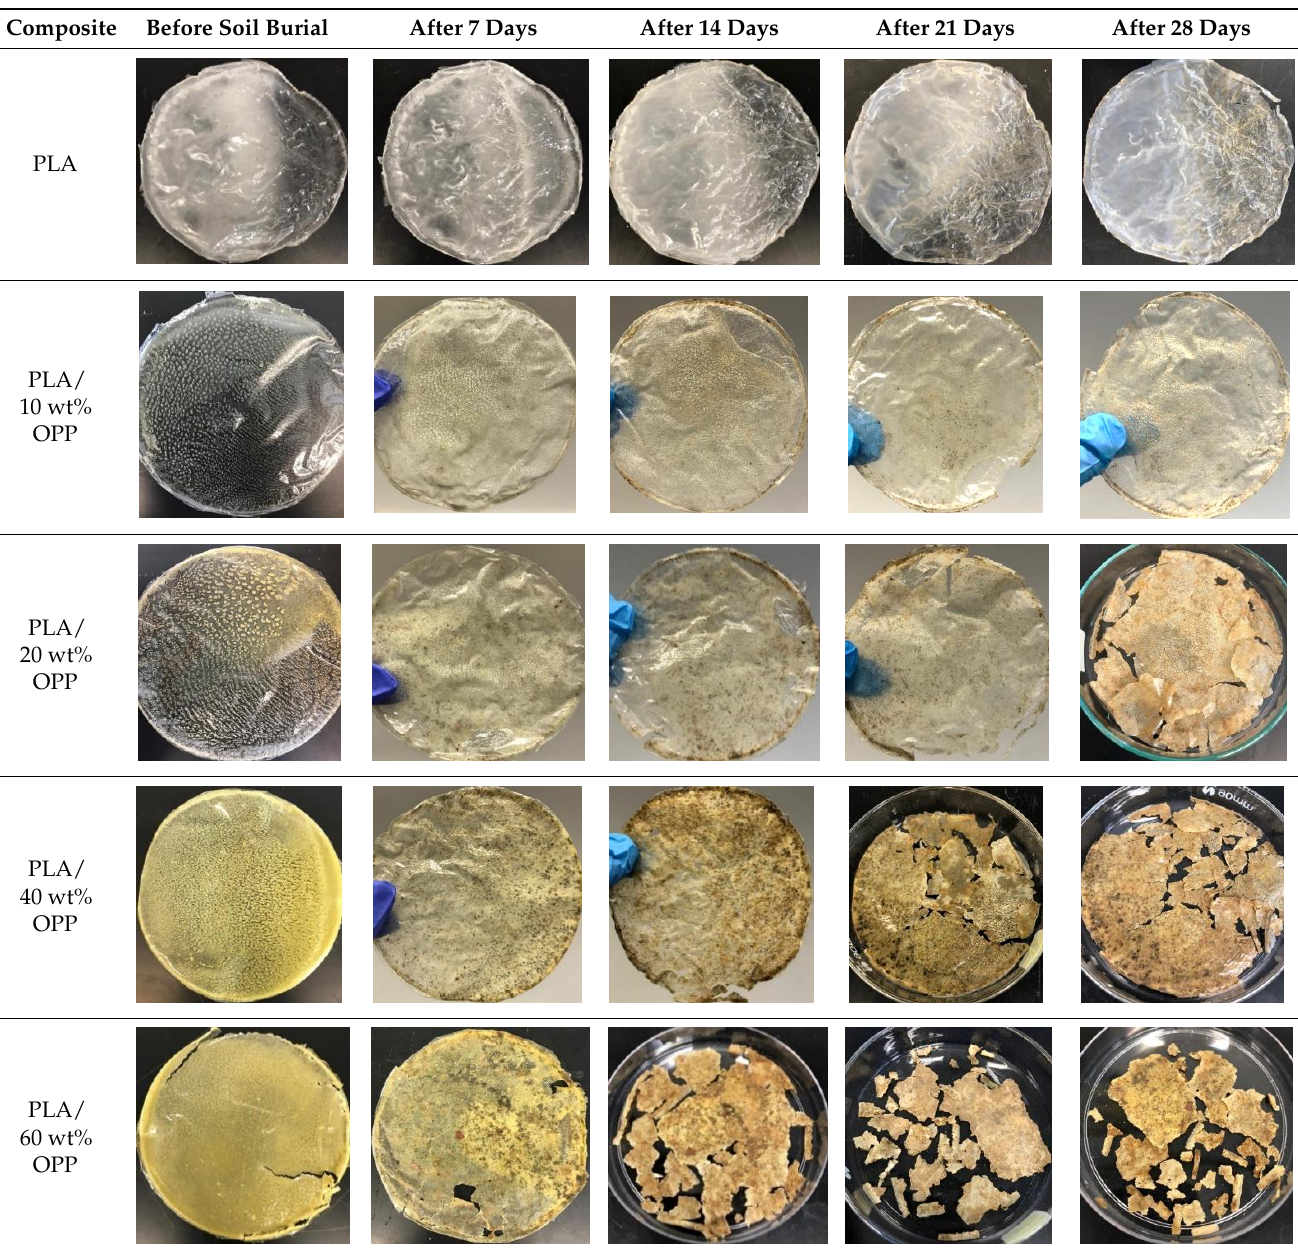
Figure 6. Weight loss percentage of composites over days after soil burial. Table 1. Physical appearance of composites before and after soil burial test.